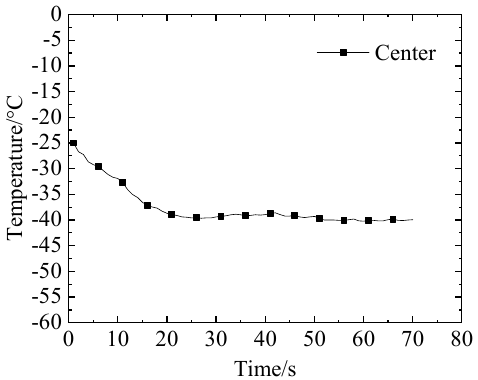
Figure 8. The temperature response curve of the central point at 0.2 Mpa without heating. The experimental data of the temperature at the center point are shown in Table 4.